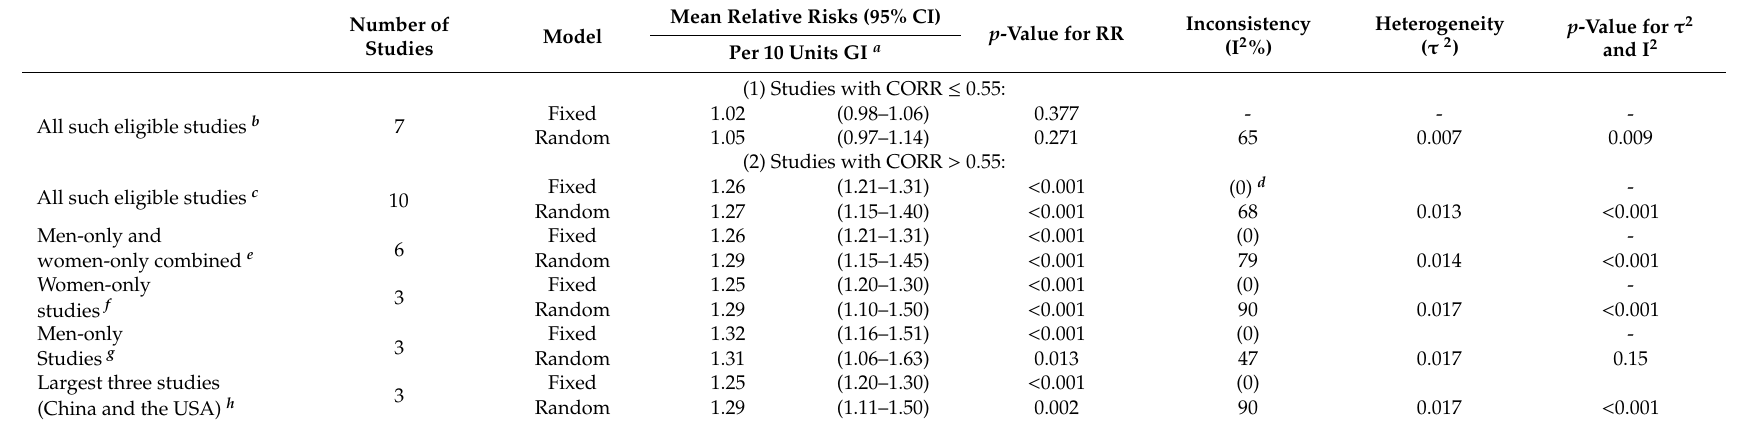
Table 1. Type 2 diabetes–glycemic index risk relations combined by a meta-analysis of the results of published prospective cohort studies using two steps: (i) Dose-response analysis and (ii) meta-analysis of the dose response